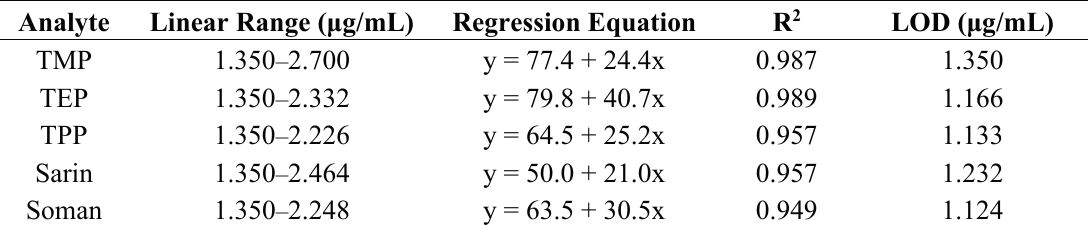
Table 2. Parameters of the proposed method for quantitative